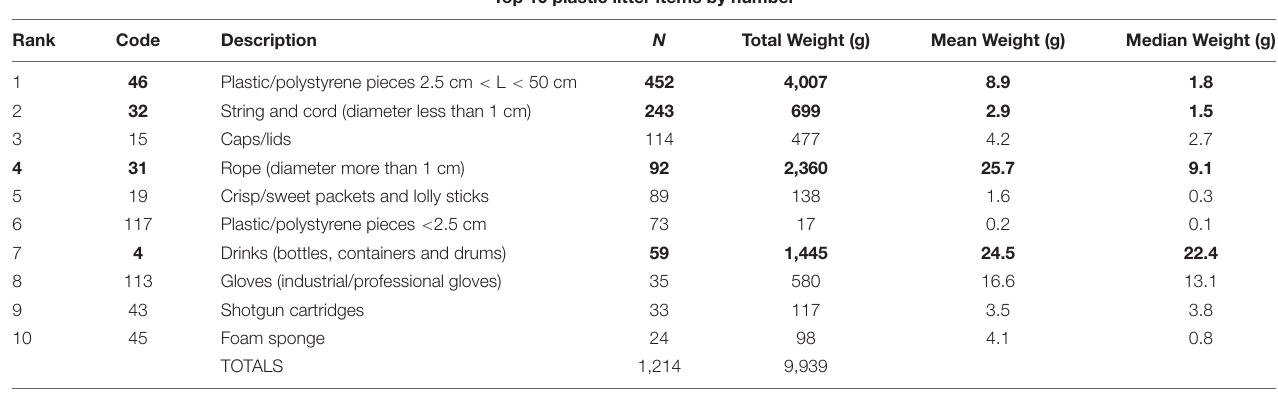
Top 10 plastic litter items by number